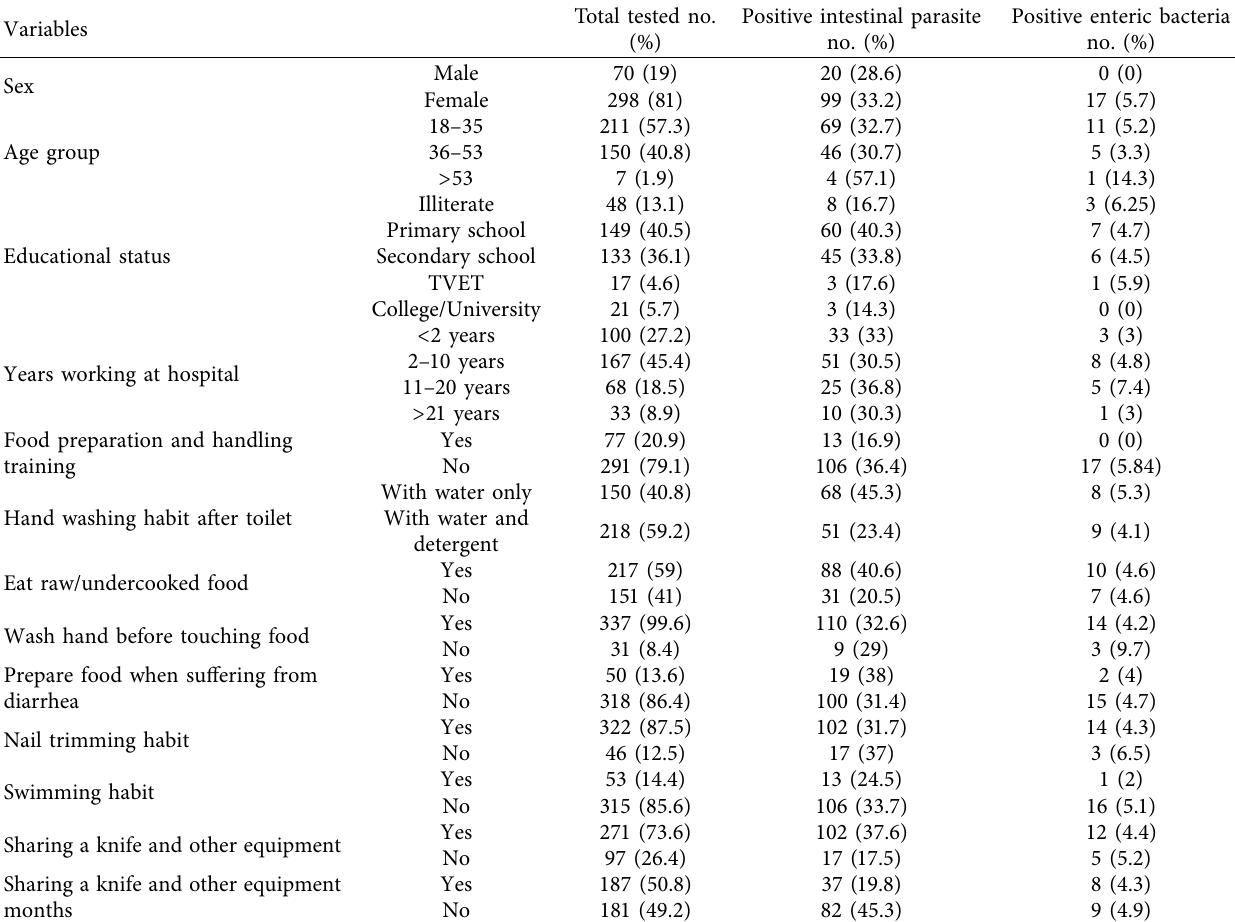
Table 2: Prevalence of intestinal parasites and pathogenic Gram-negative enteric bacteria among 6 food handlers in public hospitals, Addis Ababa, Ethiopia, March to June 2017( n �